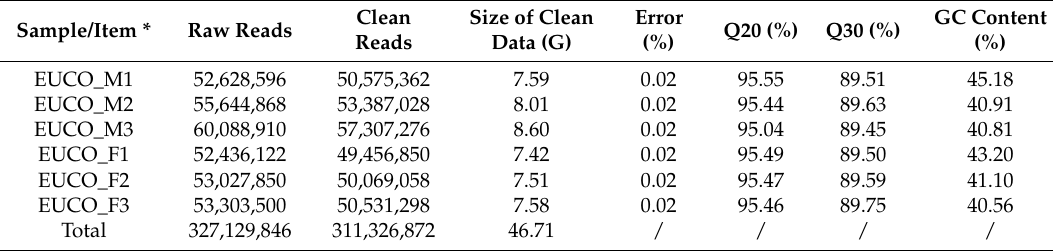
Table 1. Statistics of RNA-seq.